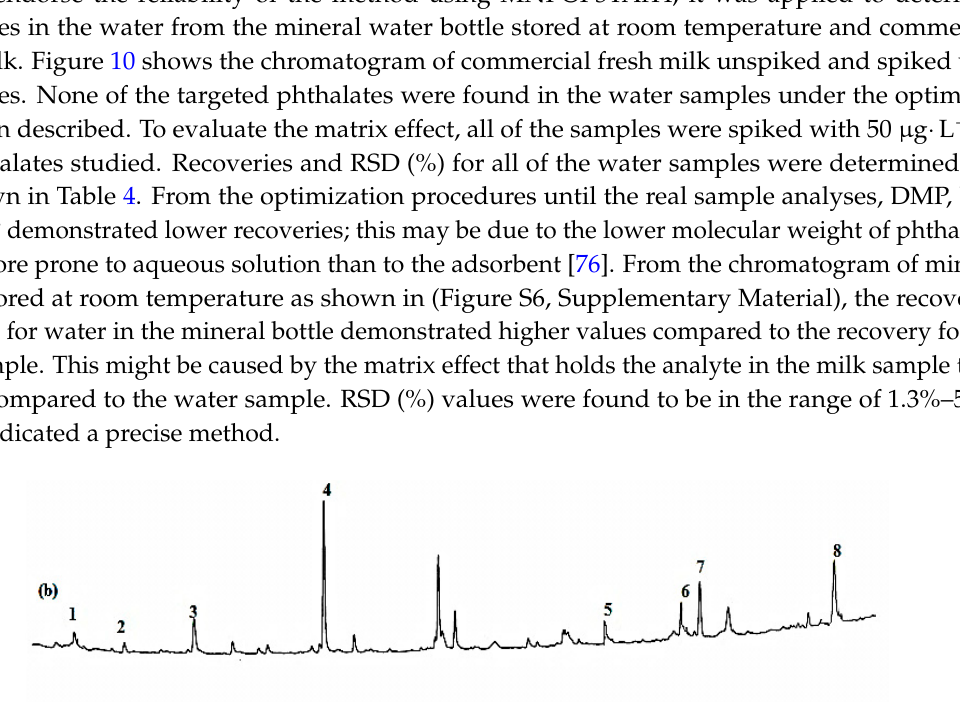
Table 4. Analysis of analytes in the real samples.